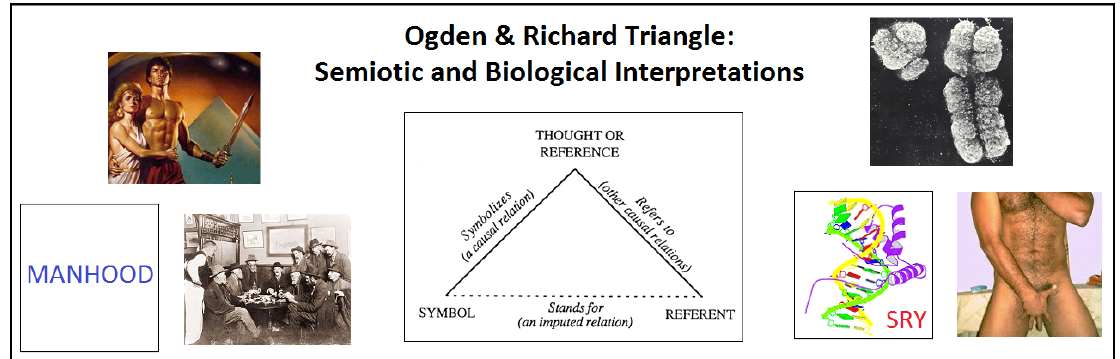
Figure 14. Ogden & Richard Triangle (middle) and its semiotic (left) and biological